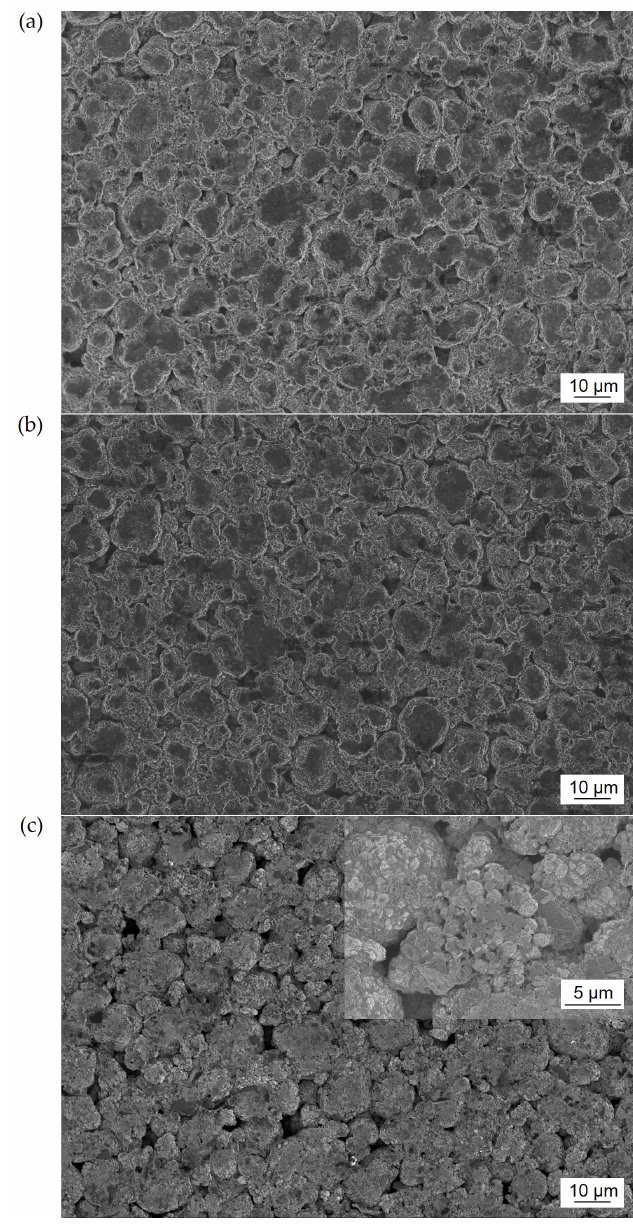
Figure 7. SEM pictures of the top surface of harvested positive electrode sheets. ( a ) BOL, ( b ) PS, ( c )